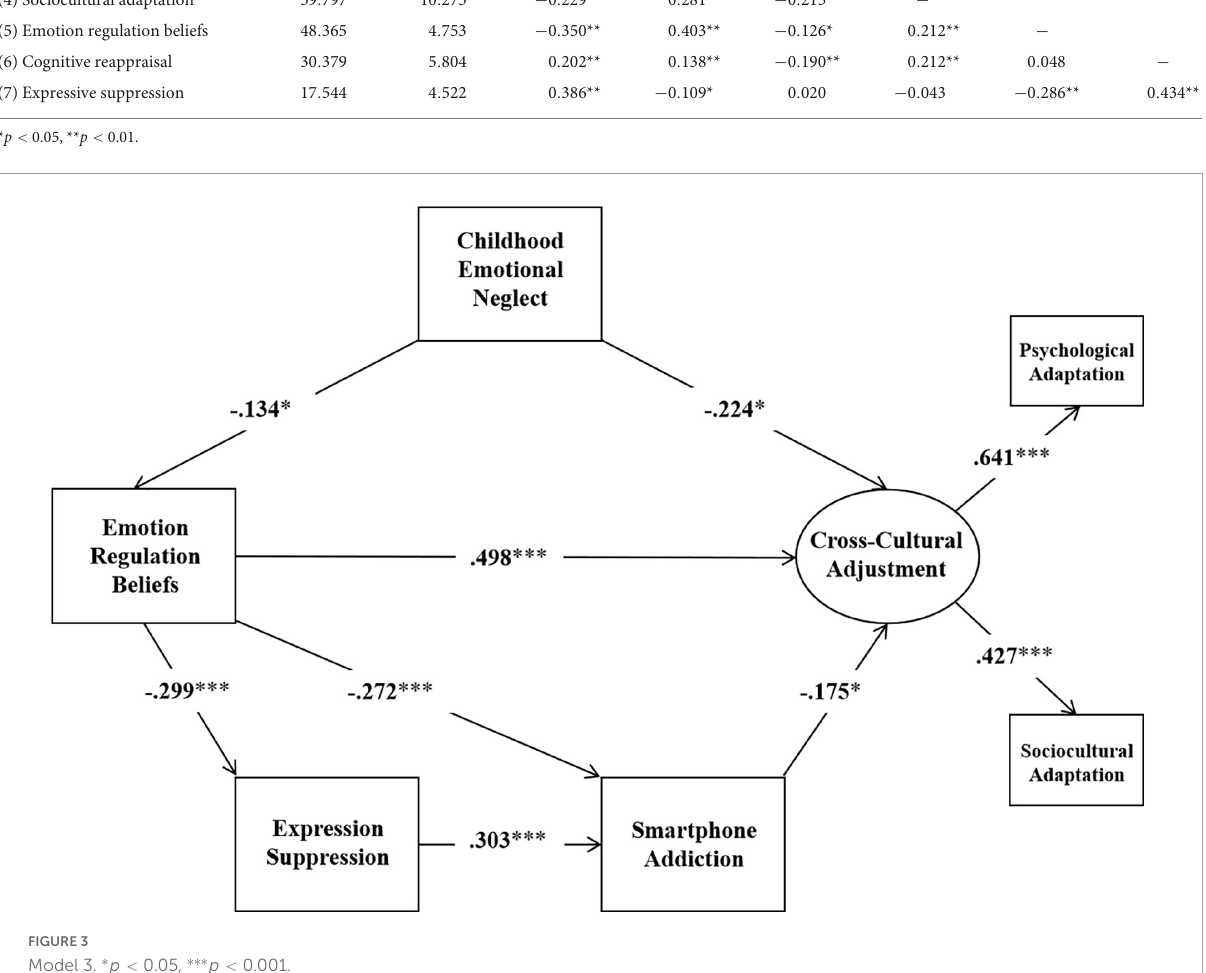
FIGURE3 Model 3. ∗ p < 0.05, ∗∗∗ p < 0.001.